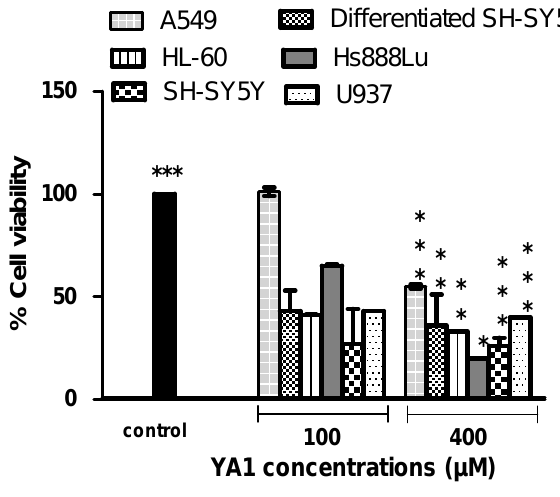
Figure 2. The response of normal and tumour cell lines exposed to 1-benzyl-3,3-dimethyl- 5-methylenepyrrolidin-2,4-dione (YA1) for 24 h. Values are means ± SD (n = 3), all comparisons were made using two-tailed Student's t -test ( * p < 0.05, ** p <